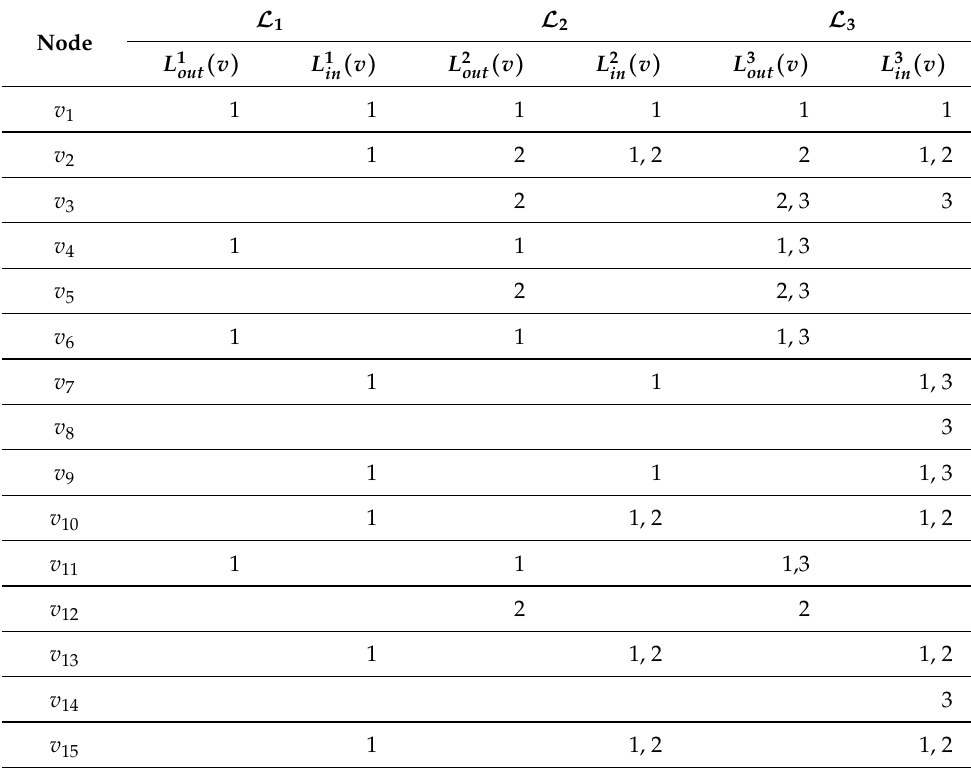
The Algorithm: The baseline algorithm (Algorithm 1) computed RR in two steps.